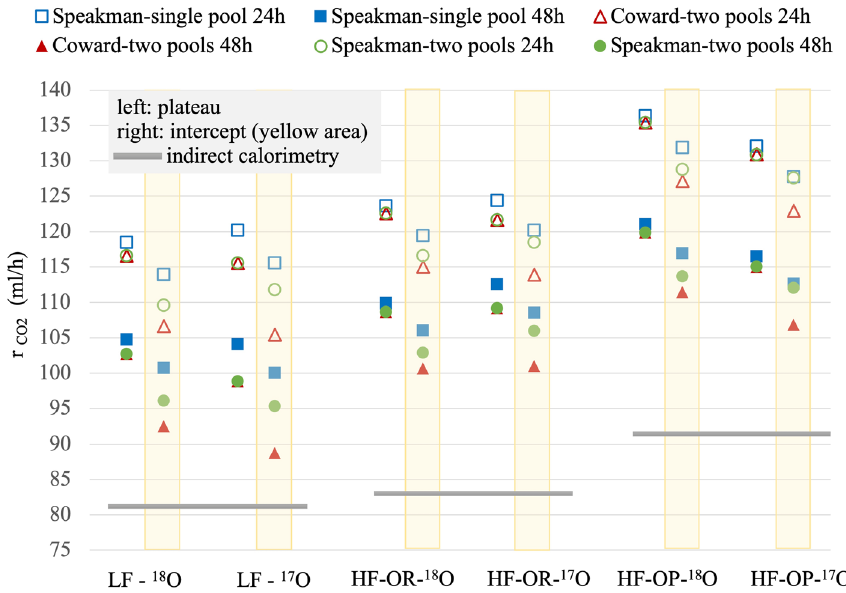
Figure 5. The average r CO2 (ml/h) of the three mice groups (LF, HF-OR and HF-OP) based on different calculation protocols. There are three models (Speakman single- or two-pools model, Coward two-pools model), two kinds of doubly labelled water method ( 18 O– 2 H, or 17 O– 2 H), two dilution space calculation methods (plateau or intercept), and two different finals (24 h or 48 h). The grey horizontal lines in the bottom are the average r CO2 values of two days from the indirect calorimetry